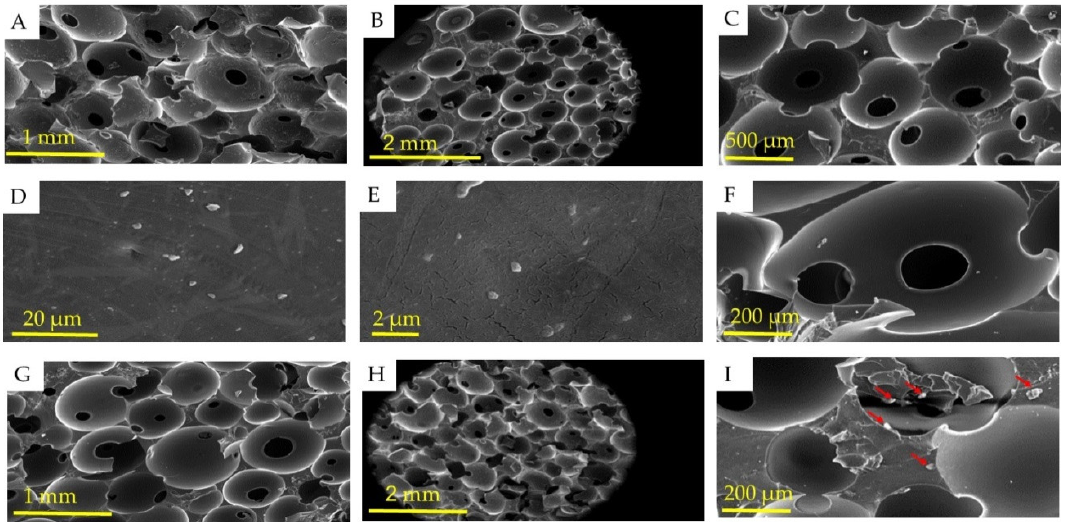
Figure 3. SEM images of PU-NL ( A – F ) and PU-NL/EEP ( G – I ) samples. The red arrows are displaying the propolis at the surface of the foam’s pore walls.